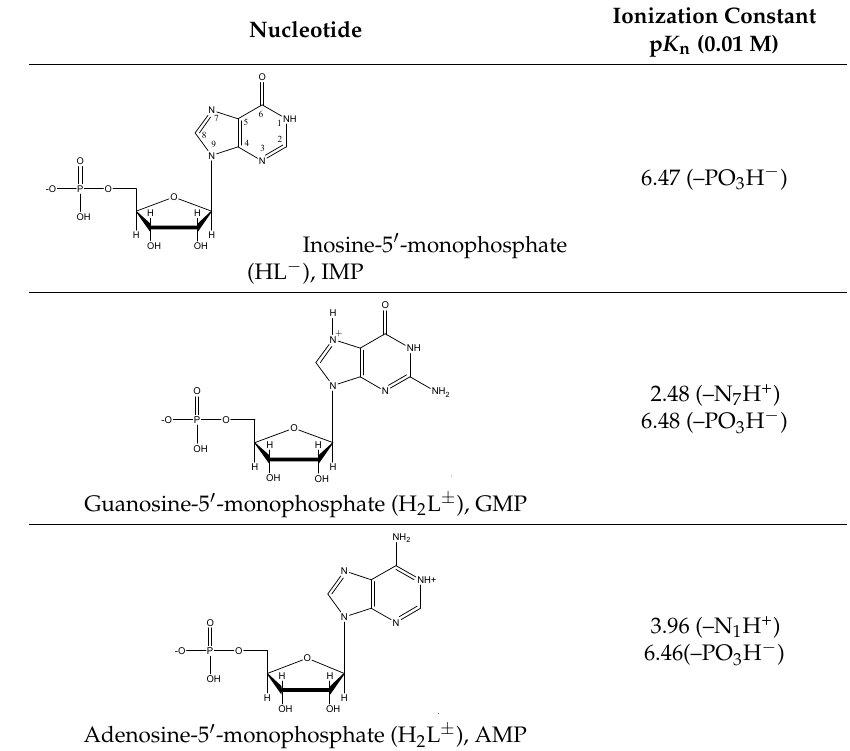
Table 3. Cont. Nucleotide